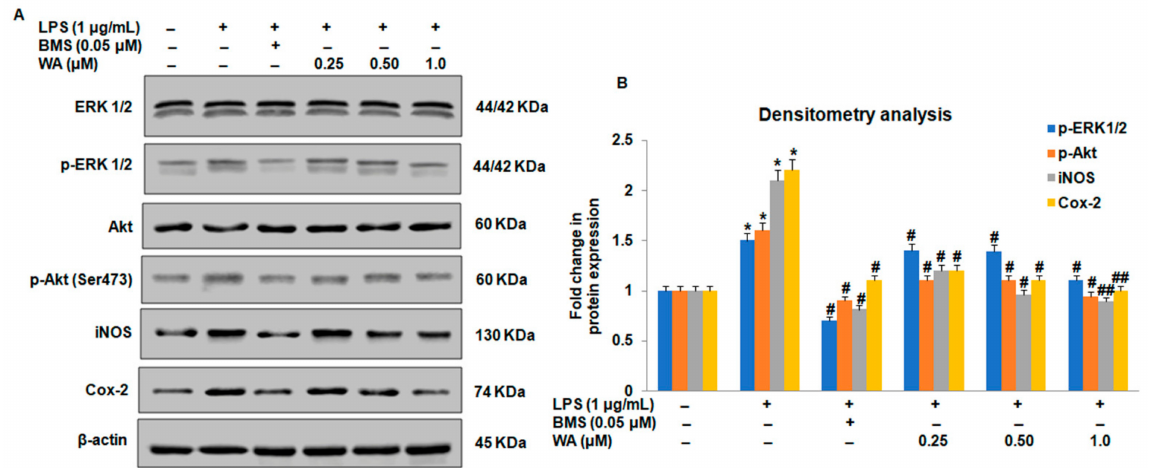
Figure 6. Effect of WA on upstream Akt-ERK1/2 and downstream mediators of the NF-kB-mediated signaling pathway in LPS-stimulated macrophages. ( A ) Protein expression and phosphorylation status by immunoblotting of Akt, ERK1/2, Cox-2, and iNOS of LPS (1 µ g/mL)-stimulated peritoneal macrophages exposed to varying doses of WA, along with the BMS (0.05 µ M), LPS-stimulated, and untreated control groups, after 48 h. ( B ) The histogram represents the fold changes in protein expression as determined by densitometry of Akt, ERK1/2, Cox-2, and iNOS of LPS (1 µ g/mL)- stimulated peritoneal macrophages exposed to varying doses of WA, along with the BMS (0.05 µ M), LPS-stimulated, and untreated control groups, after 48 h. Experimental data are presented as the mean ± SEM of three or more independent experiments. * p ≤ 0.05 (comparison vs. LPS only), # p ≤ 0.05, and ## p ≤ 0.01 (comparison vs. +LPS) are statistically significant.